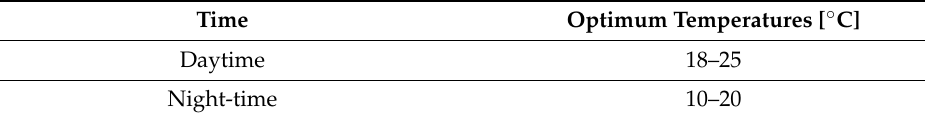
Table 1. Optimum temperatures for tomato growth [3]. Figure 2. Hierarchy of the different geometry and HVAC abstractions in OpenStudio/EnergyPlus.